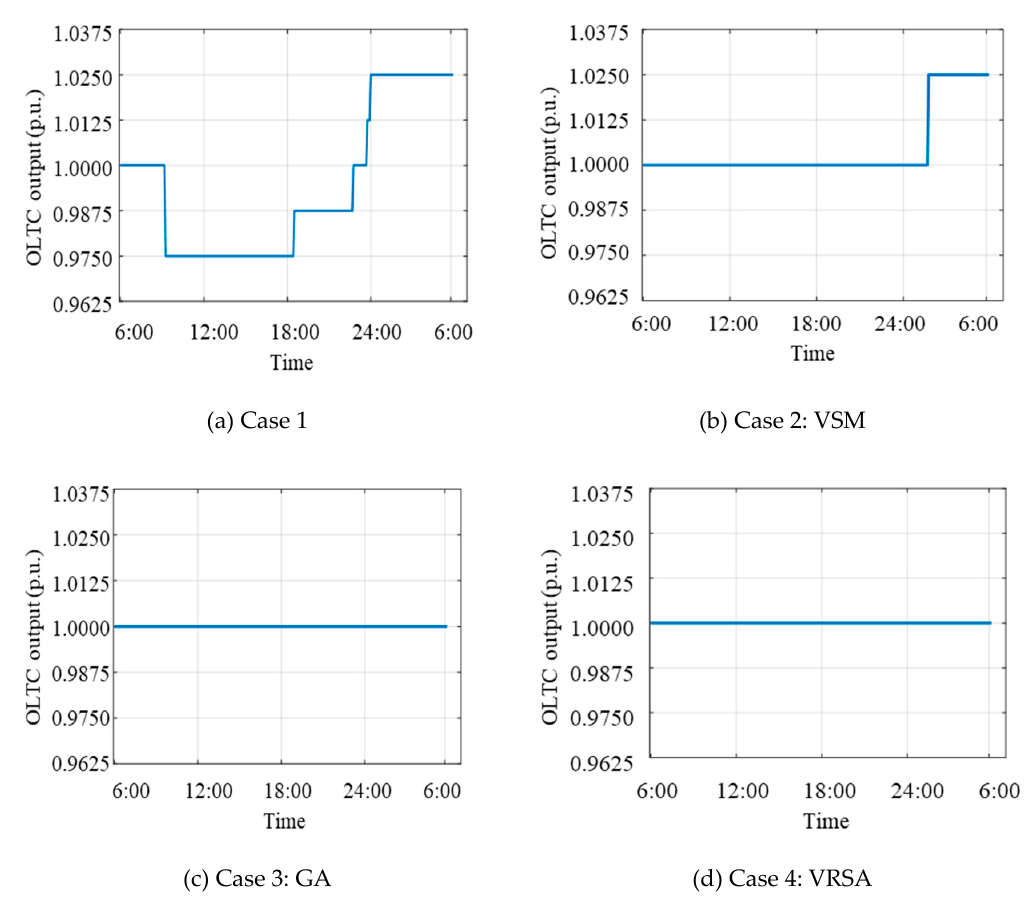
Figure 13. On-load tap changer (OLTC) operation of the four cases.